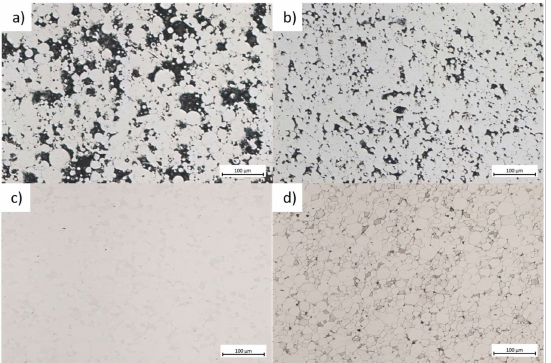
Figure 8. Typical microstructures of sintered materials ( a ) 380 ◦ C/480 s ( b ) 400 ◦ C/480 s ( c ) 420 ◦ C/480 s ( d ) 440 ◦ C/480 s.